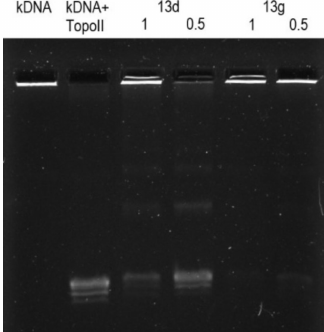
Figure 7. Inhibition of topoisomerase II α by 13d and 13g at 0.5 and 1 mM